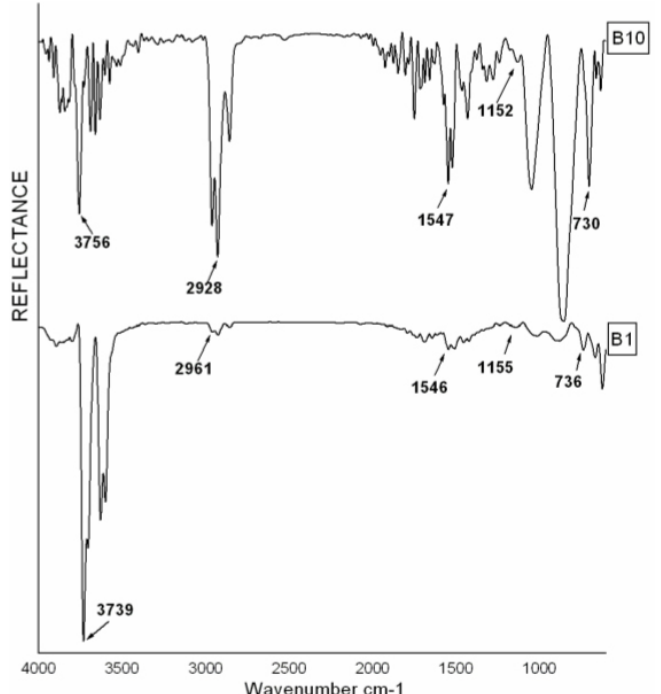
Figure 3. Overlaid FTIR-VAR (reflectance) spectra, region 4000-600 cm -1 for geological Baltic amber (B1), and archaeological Baltic amber from Denmark (B7).